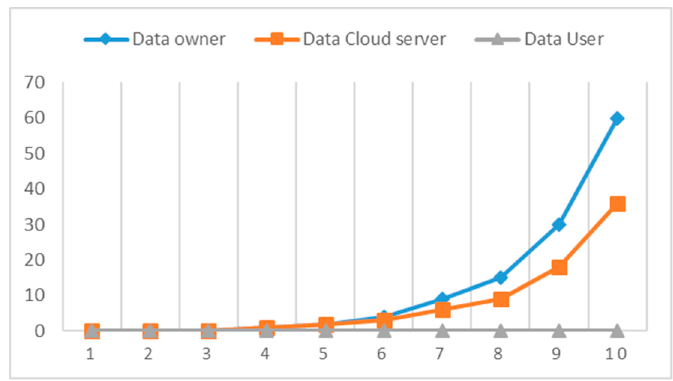
Figure 11. Average execution time for the user.